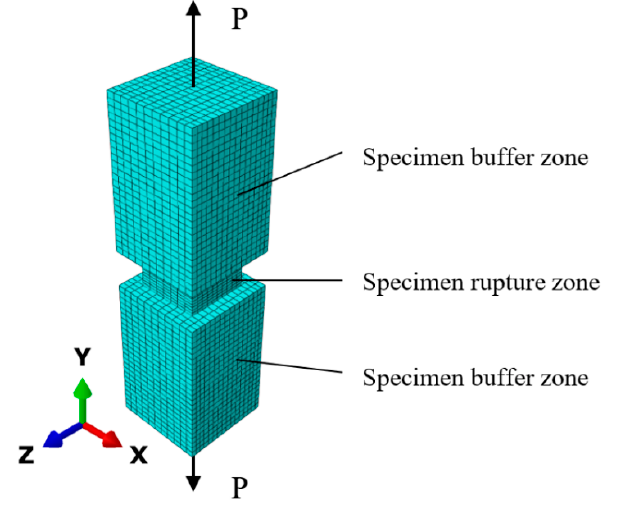
Figure 8. Finite element model for the simulation of concrete under uniaxial tension.